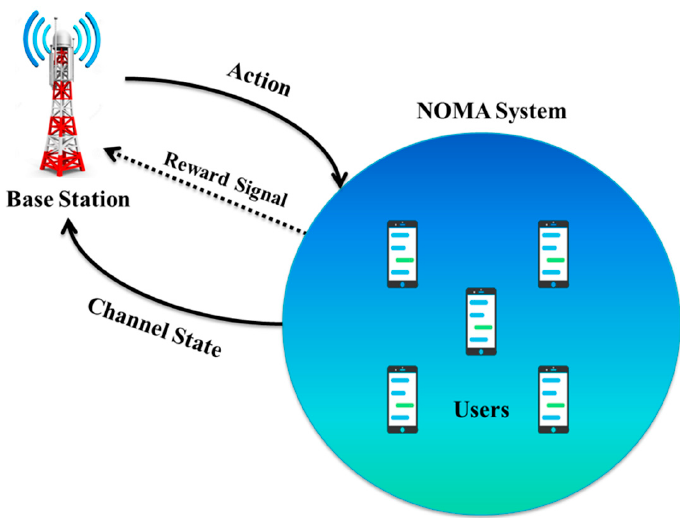
Figure 3. Power allocation and channel assignment of DL-based NOMA system. Table 2. Summary of studies on DL-based power allocation types in NOMA.